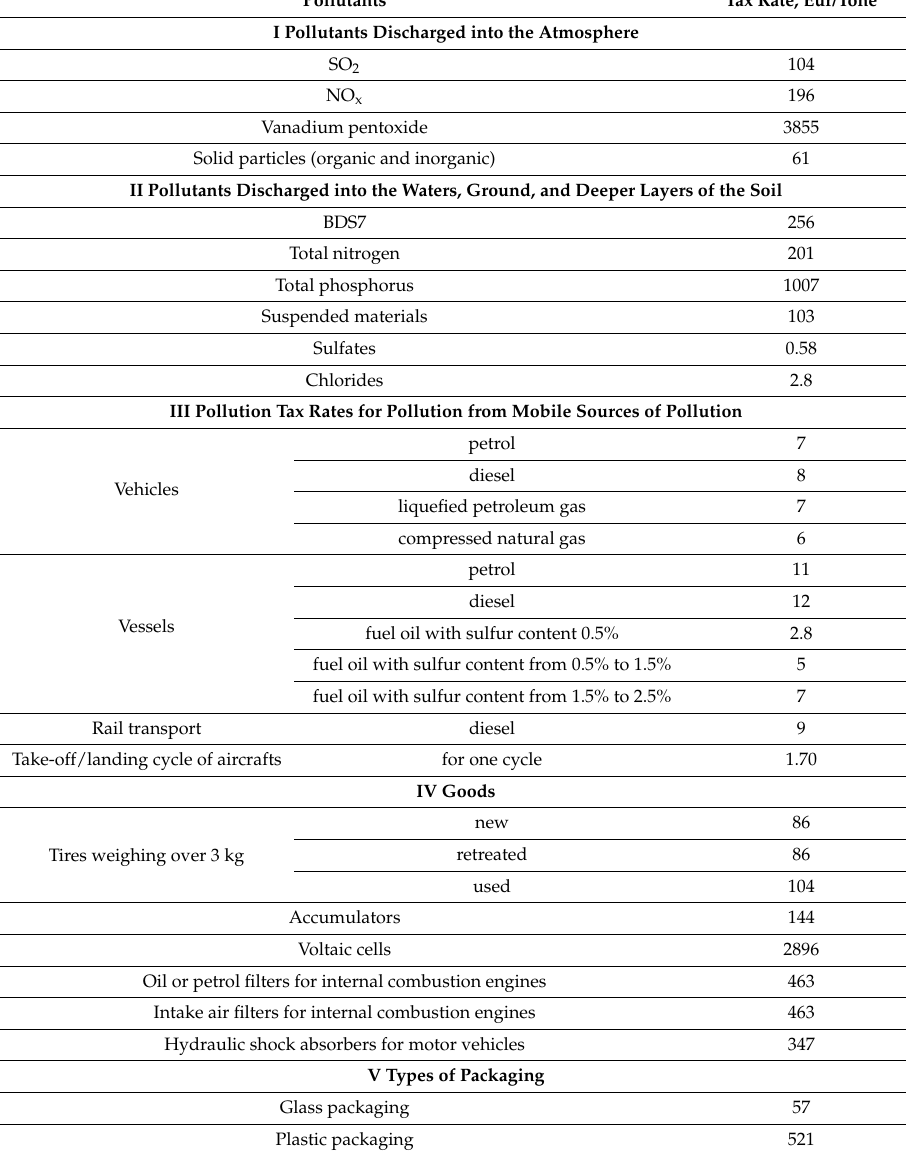
Table 6. The tax rates for pollutants in Lithuania, 2015